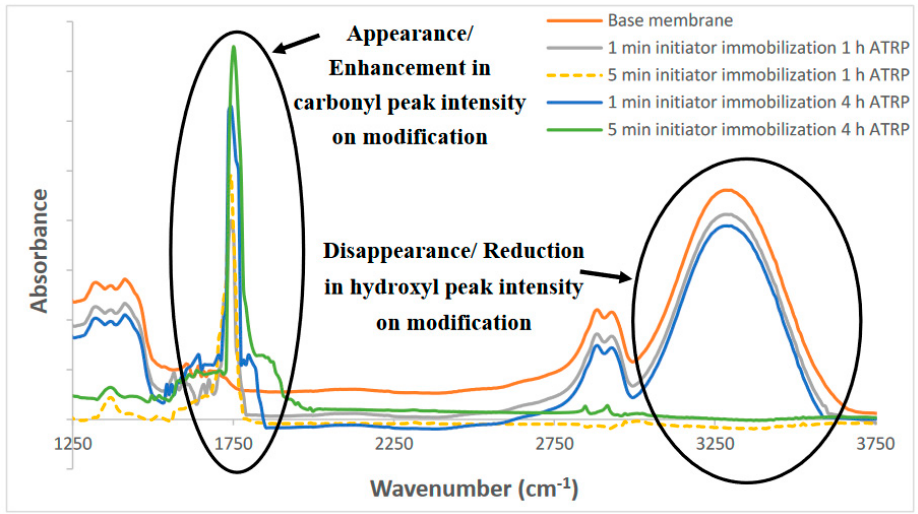
Figure 2. Attenuated total reflectance Fourier-transform infrared (ATR-FTIR) spectra for the base and modified membranes. ATRP: atom transfer radical polymerization.